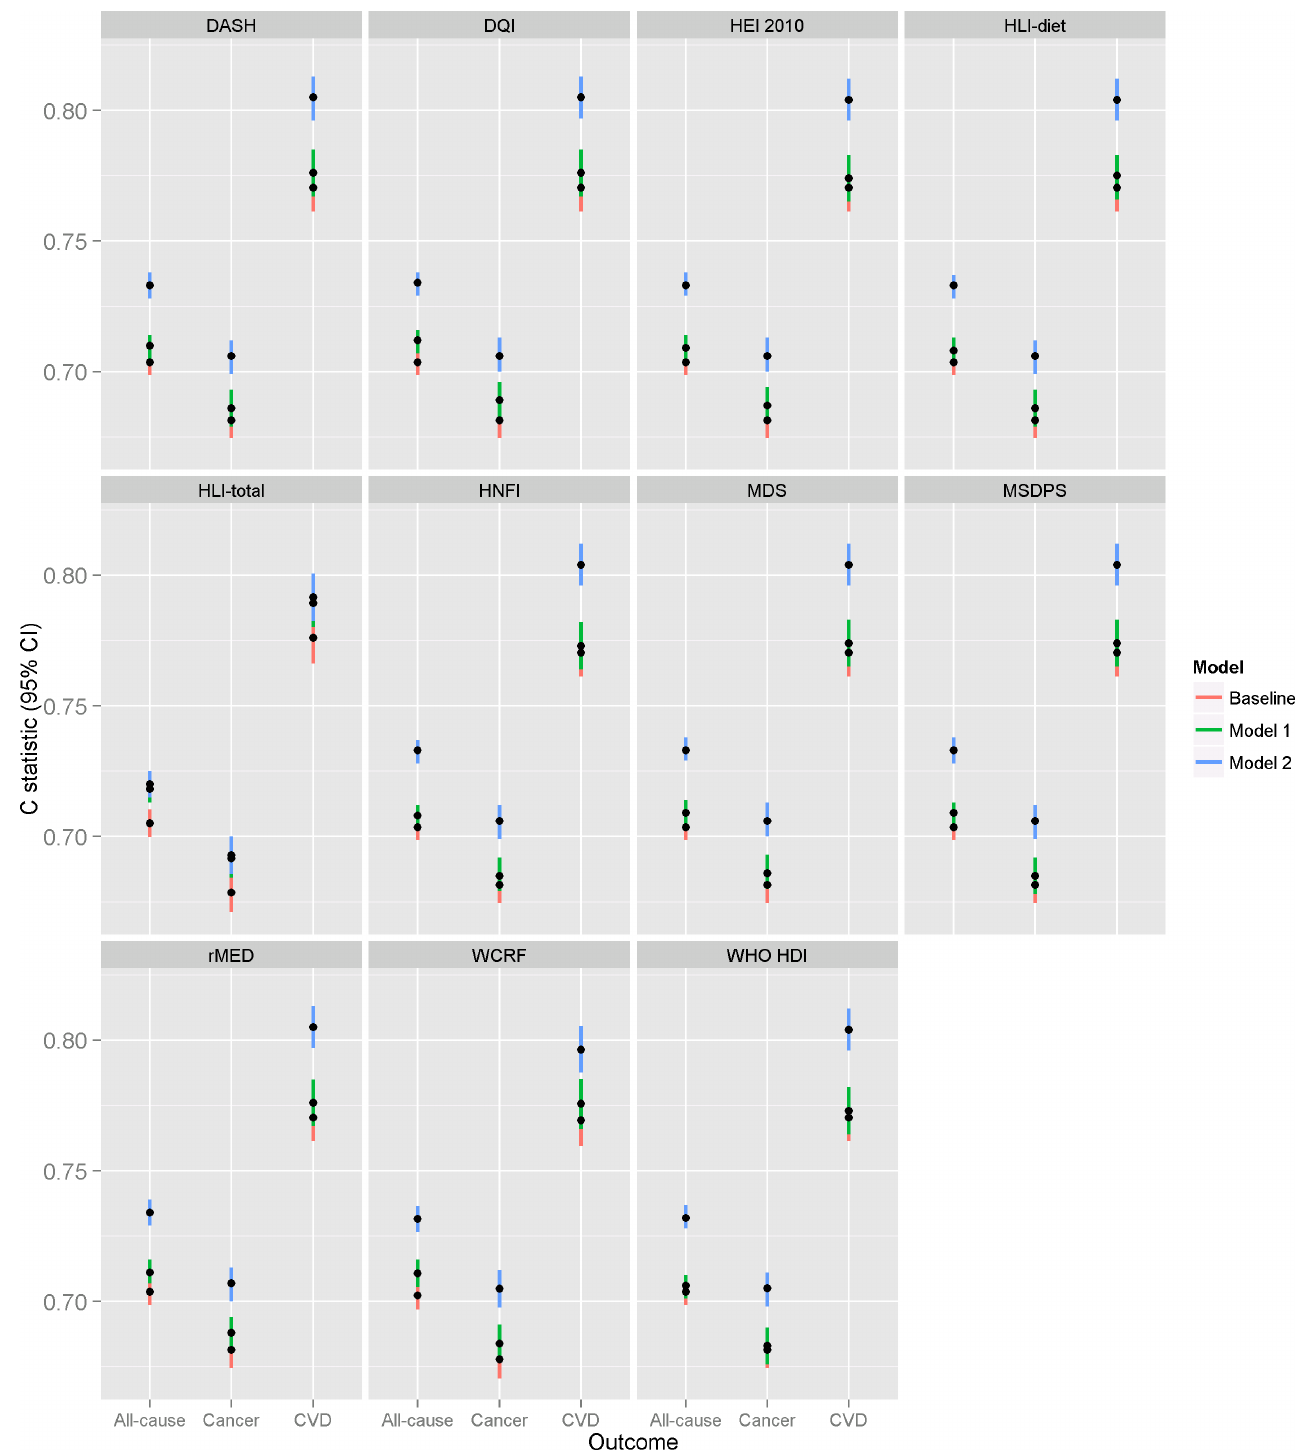
Fig 1. Discrimination (Harrell ’ s C statistic) of the baseline model a , Model 1 b and Model 2 c for the prediction of 10-year mortality risk in 451,256 d,e participants to the EPIC study. Abbreviations: MDS, Mediterranean Diet Scale; rMED, relative Mediterranean diet score; MSDPS, Mediterranean Style Dietary Pattern Score; DQI-I, Diet Quality Index – International; HNFI, Healthy Nordic Food Index; HEI-2010, Healthy Eating Index 2010; WHO HDI, World Health Organization Healthy Diet Index; DASH, Dietary Approaches to Stop Hypertension; HLI, Healthy Lifestyle Index; HLI-diet, diet component of the HLI; WCRF, World Cancer Research Fund / American Institute for Cancer Research a Baseline model